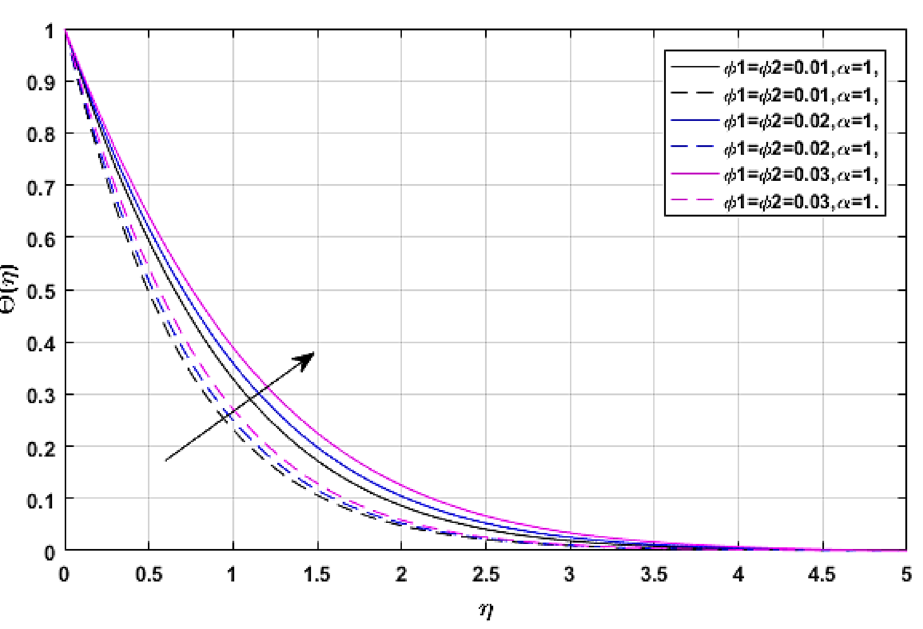
Figure 9. φ 1 , φ 2 versus temperature field when M = (cid:31) = E = Ec = 0.1, Pr =